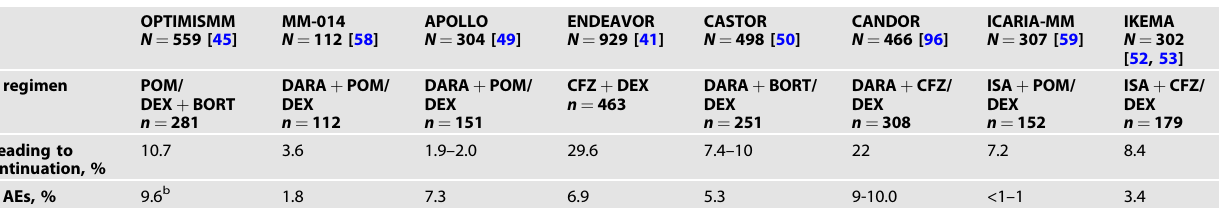
Table 4. Toxicity considerations across phase 2 and 3 RRMM clinical trials a .